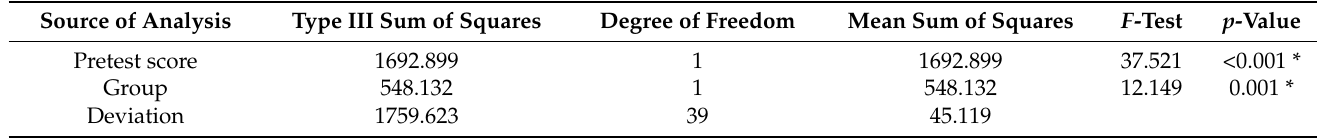
Table 6. Summary of ANCOVA analysis results.